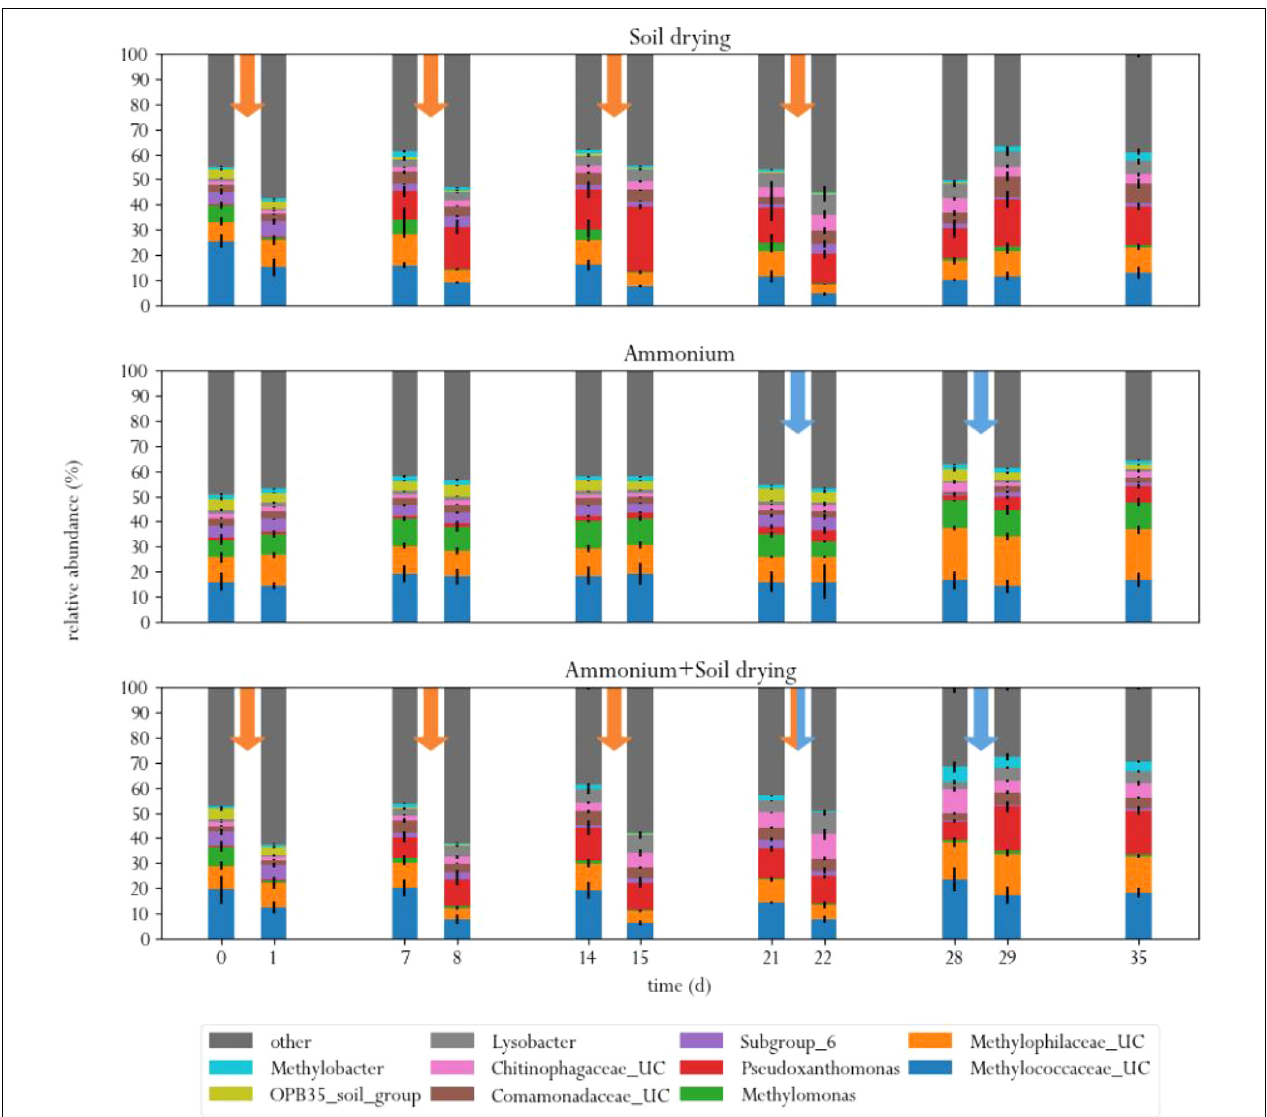
FIGURE 4 | Relative abundances of ten most abundant bacterial genera in the three different treatments, before and after each perturbation. Orange arrows indicate soil drying events, blue arrows indicate ammonium addition to the corrensponding treatments.